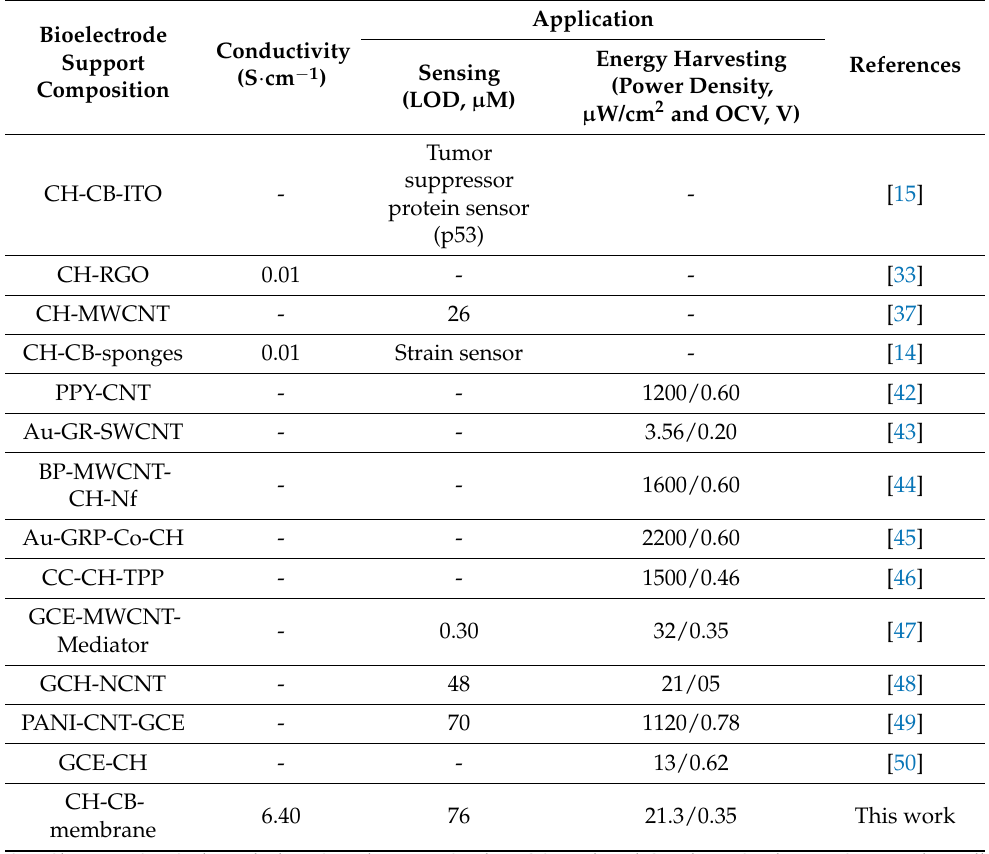
Table 2. Flexible and conductive bioelectrodes based on polymeric-carbon materials and glucose- related